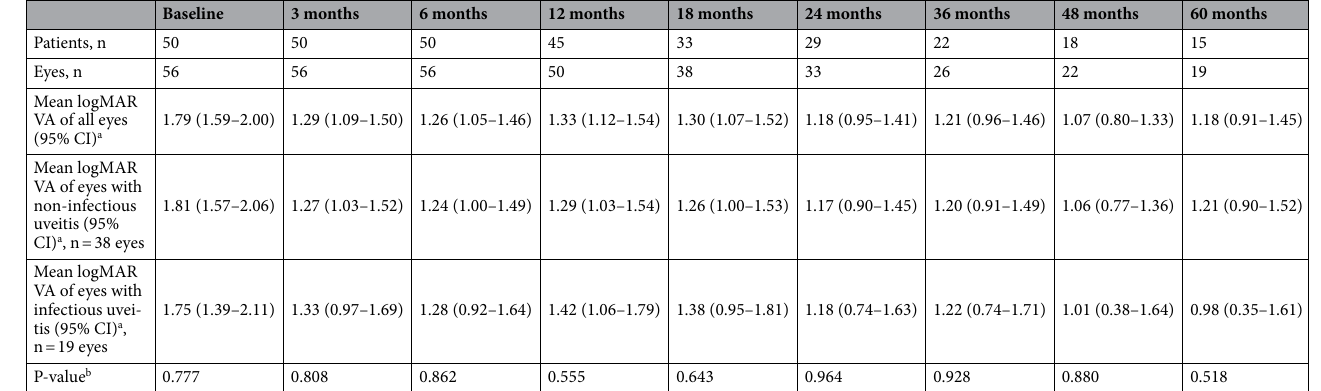
Table 4. Estimated mean logMAR VA of all eyes and in eyes categorized into the non-infectious and infectious uveitis groups. CI confidence interval, logMAR logarithm of the minimum angle of resolution, VA visual acuity. a Derived from mixed-effects random intercept linear regression model. b P-value of Wald test comparing VA at each timepoint between the non-infectious and infectious uveitis